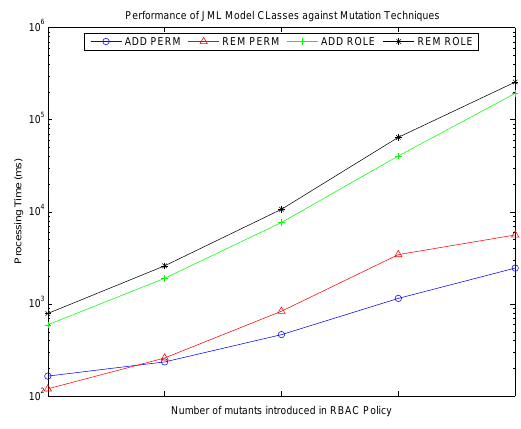
Table 3. ExperimentalData UsingJET.